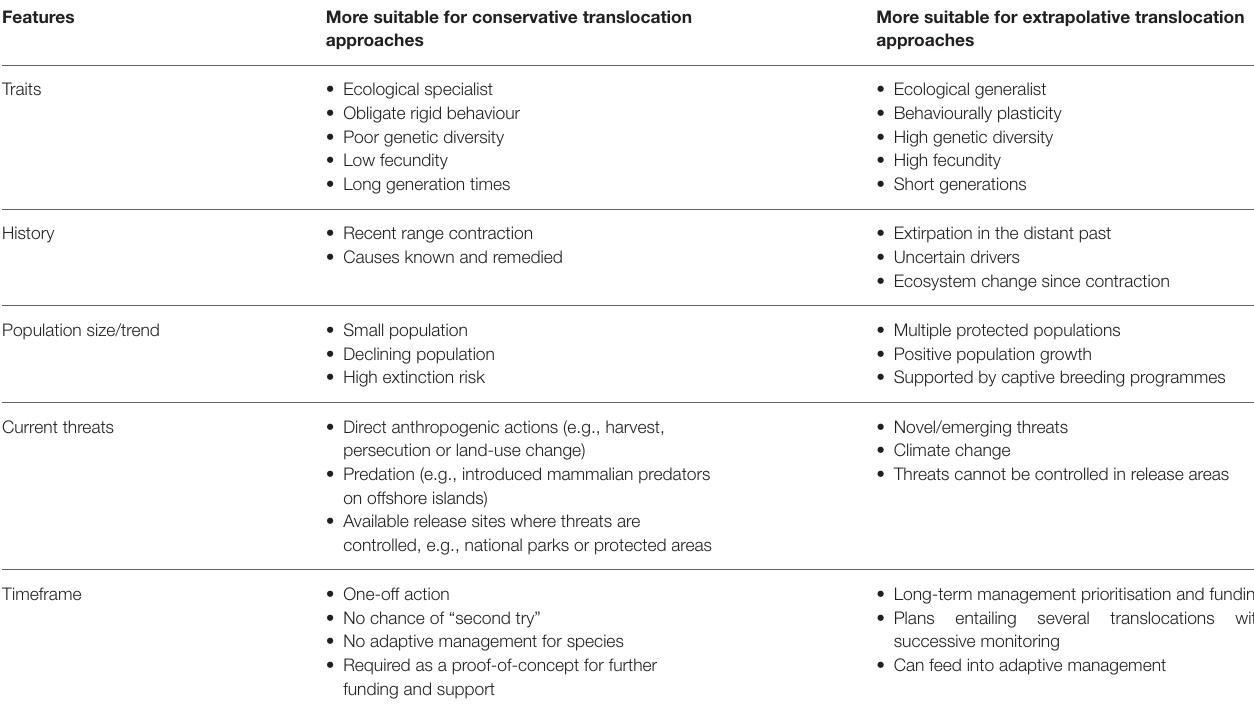
TABLE 1 | Summary of conditions lending themselves to conservative and extrapolative translocation management.